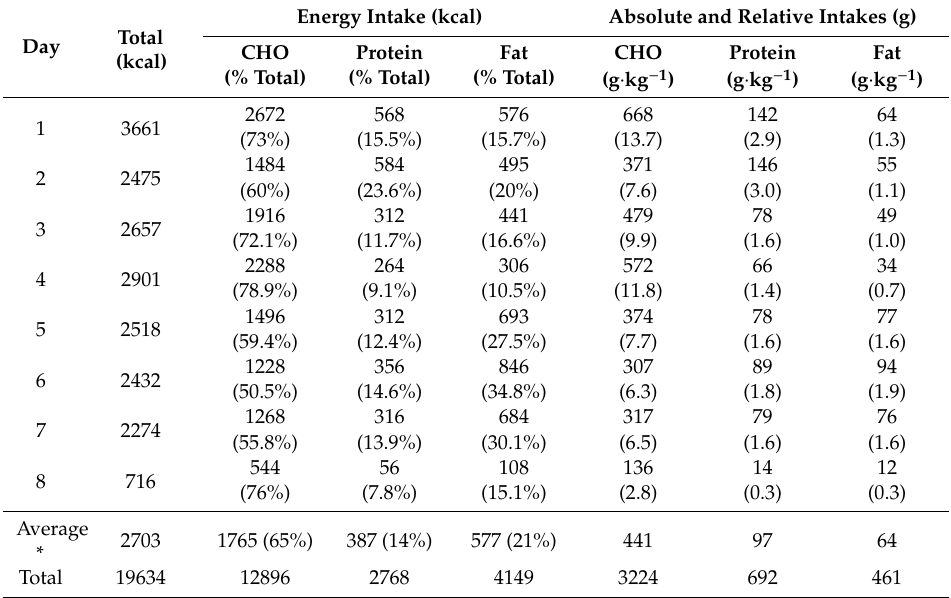
Table 2. Daily energy intake derived from carbohydrate (CHO), protein, and fat during the world record